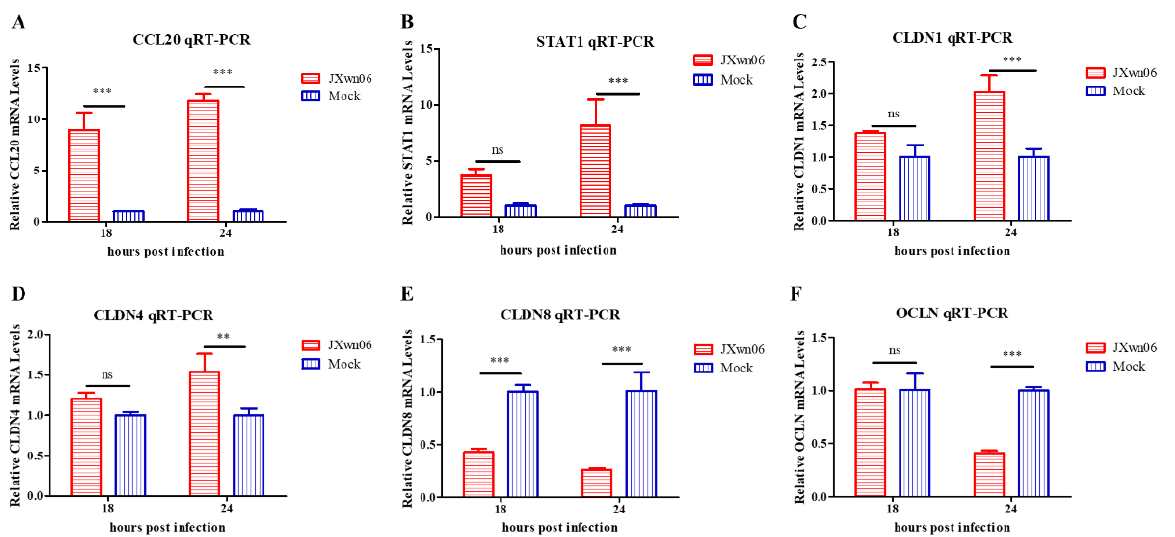
Figure 7. RT-qPCR validation of differentially expressed genes in PMVECs upon interaction with HP- PRRSV-infected PAMs at different time points. Shown are the transcription levels of four upregulated genes ( A – D ), and two downregulated ones ( E , F ). The levels of these genes were normalized against β -actin and then compared to the mock-infected group. The data are shown as means ± SD (standard deviation), n = 3 independent experiments performed in triplicate. Asterisks indicate statistical significance (ns, p > 0.05; **, p < 0.01; ***, p < 0.001).